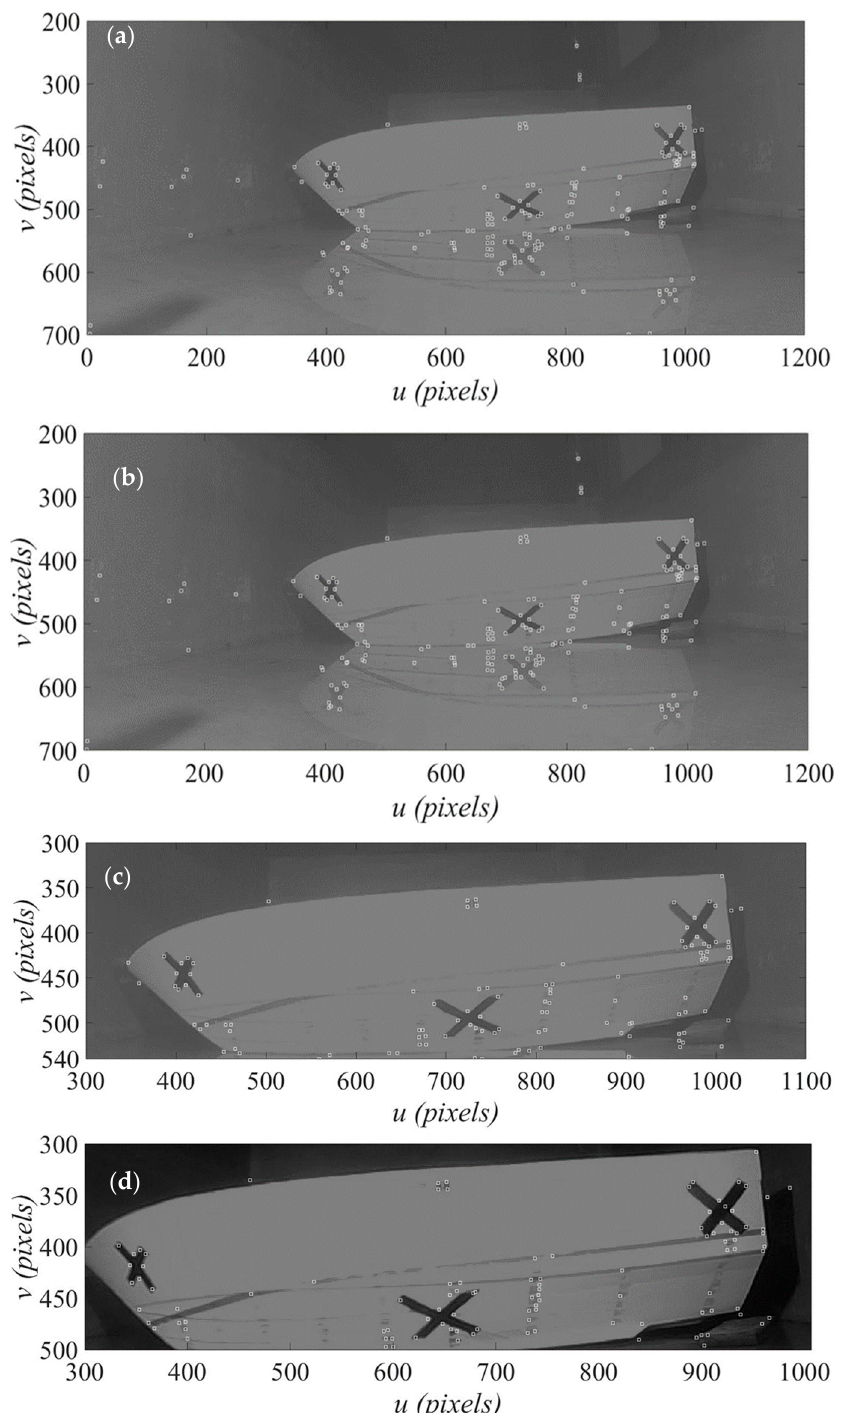
Figure 22. Results of ( a ) left and ( b ) right images; and partial enlargement of ( c ) left and ( d ) right images from Harris corner detection on the ship model in the out-of-water environment.